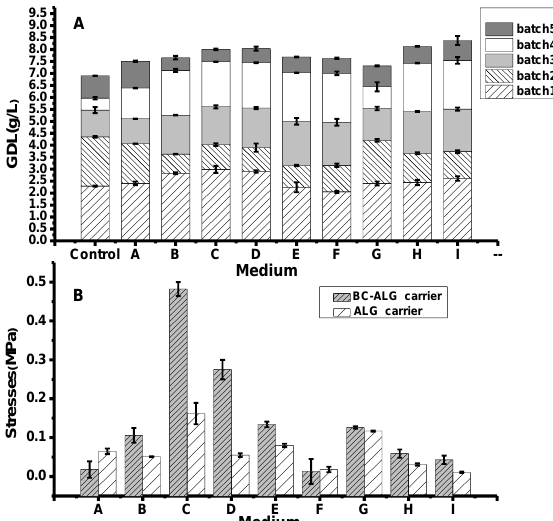
Figure 1. Comparison of gamma-decalactone (GDL) production based on different BC-ALG carriers ( A ) and the compressive strength of BC-ALG and ALG carriers ( B ). The group names A–I represent the carrier with different compositions according to Table 1.